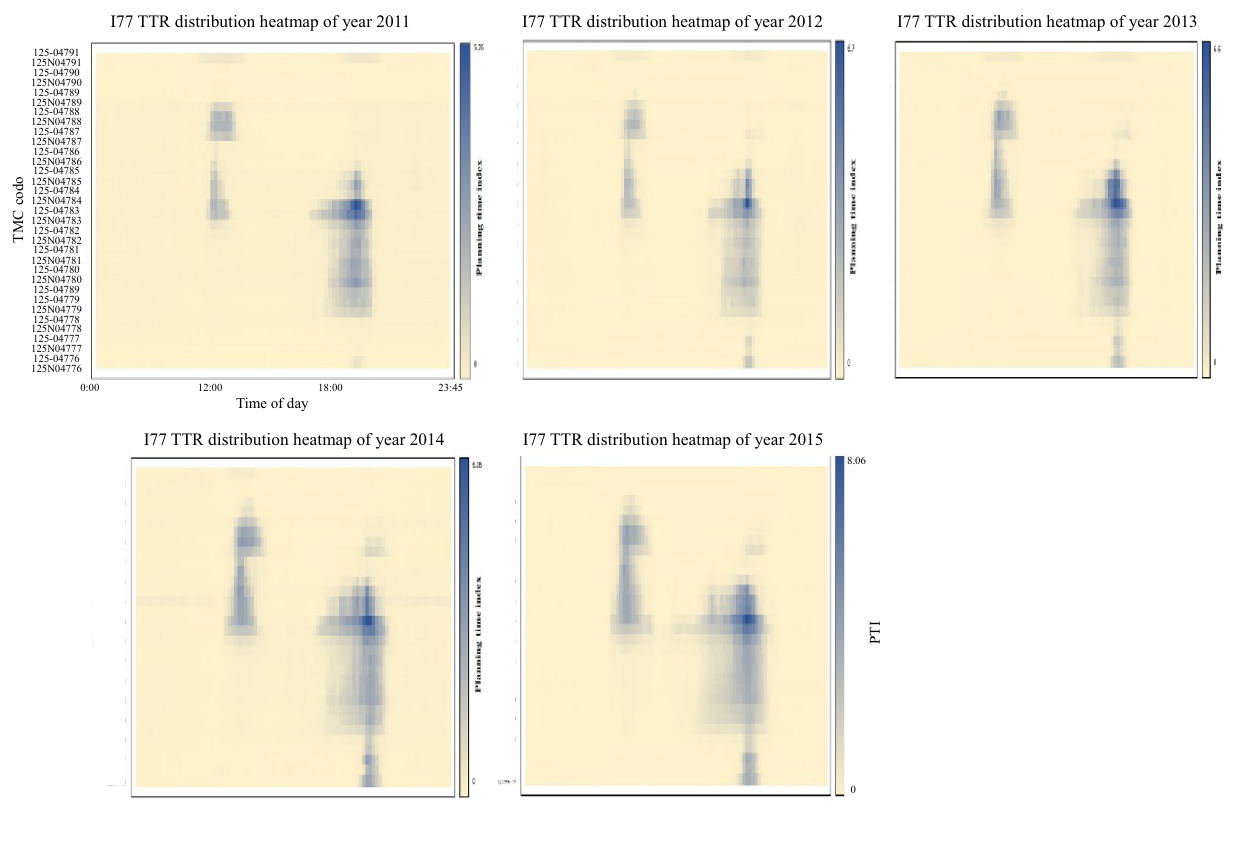
Fig. 2 PTI heat maps of I-77 segments in 5